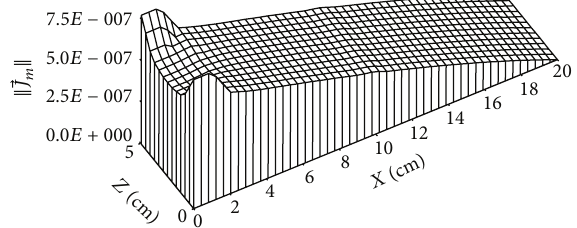
Figure 17: Distribution of heat flow due to phase change (in W/m 2 ) for 𝑡 = 135 days.